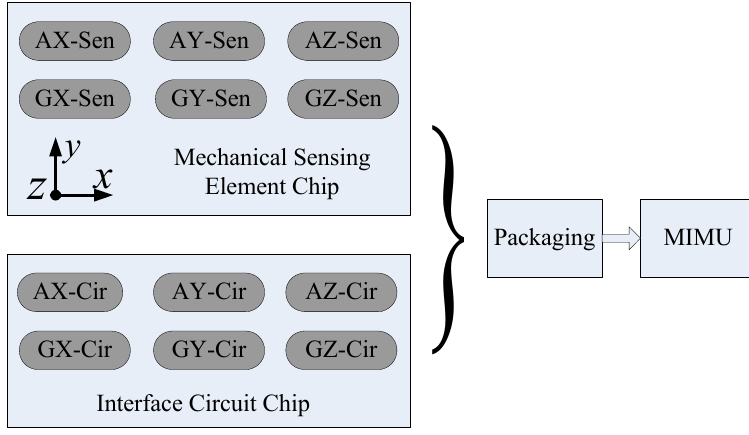
Figure 1. Schematic of the two-chip integration